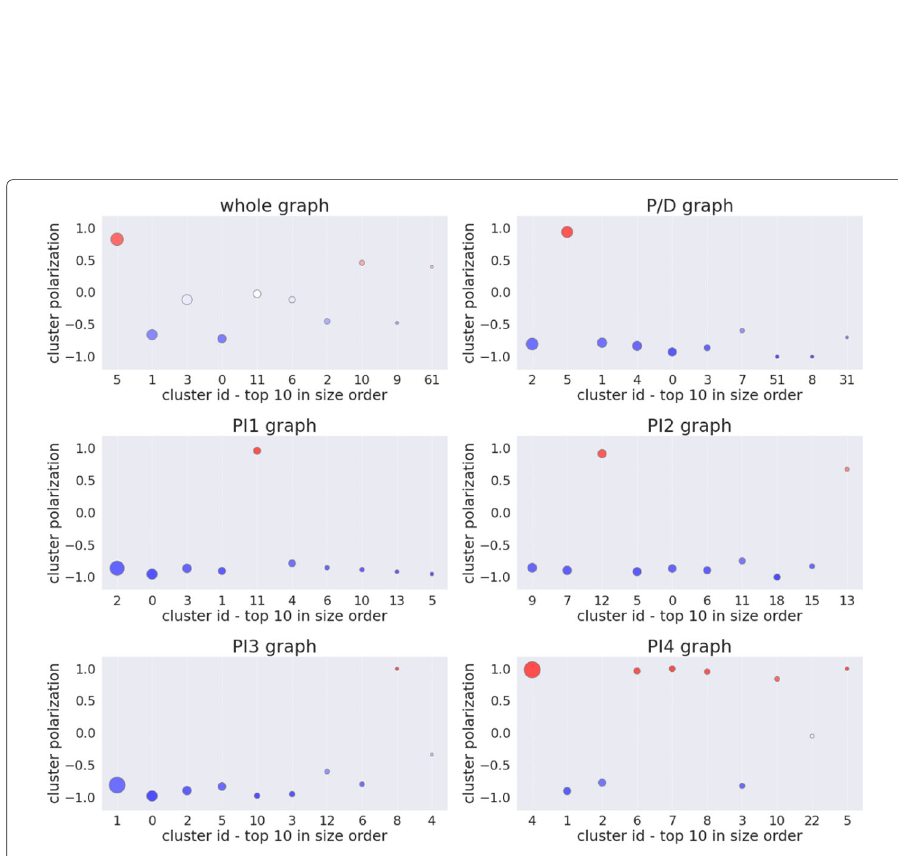
Fig. 5 The polarization of the top 10 clusters for each of the six graphs. The marker size is proportional to the cluster size. The polarization is also visible from the marker